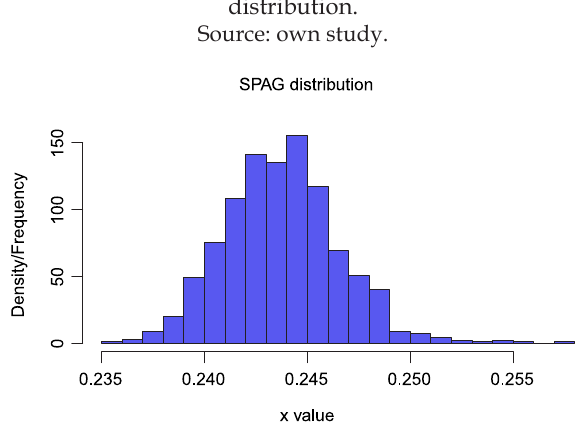
Fig. 10. Histogram of SPAG. Source: own